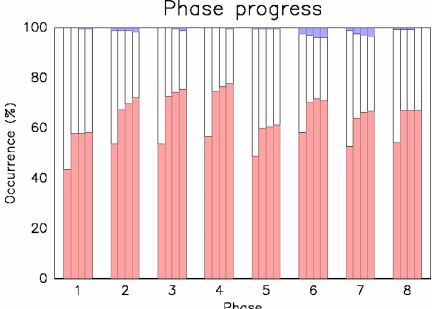
Figure 10. Percentage of forward (red) and backward (blue) phase progress starting from each phase. Four bars from left to right in each column correspond to time lags of 1 to